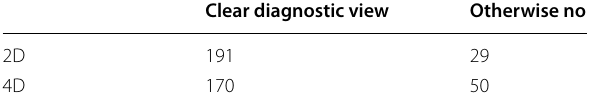
χ 2 6.804, P value =